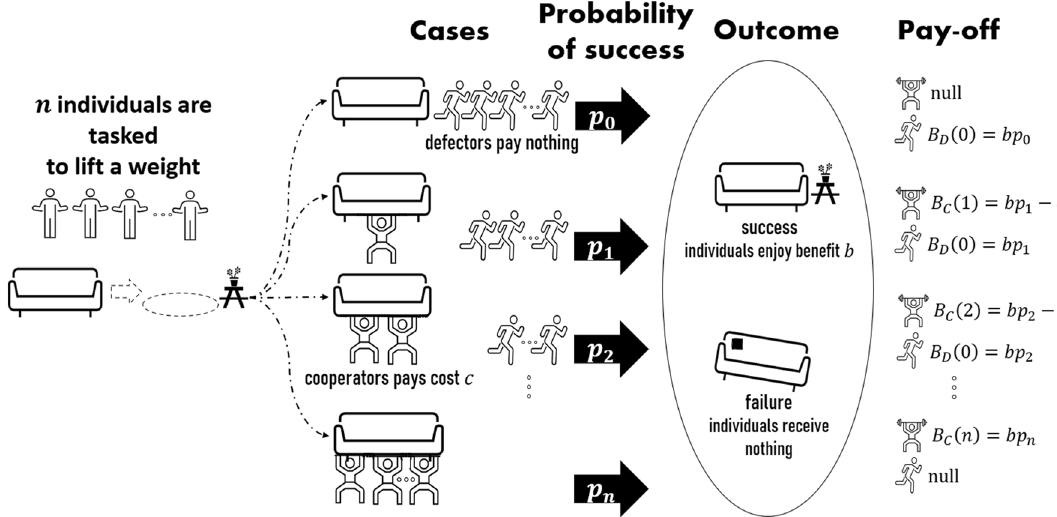
Figure 1. A schematic diagram of the n -player weightlifting game. In this game, players decide whether to cooperate or defect in carrying the weight. Cooperators need to pay a cost. The weightlifting can either succeed or fail. In case of success, all players receive a benefit. In case of failure, all players receive nothing. The player’s pay-off depends on the benefit, cost and probability of success. Each player decides whether to cooperate or defect so as to maximize the expected gain.